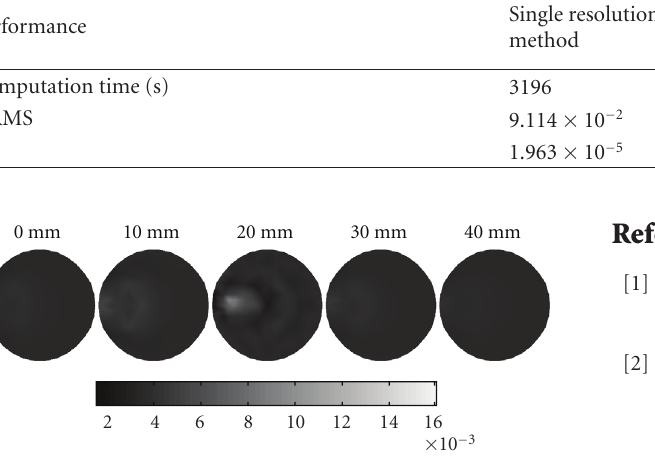
Figure 11: Reconstructed images using the single resolution method, which are 2D cross sections through the reconstructed 3D volume. The right-hand side corresponds to the top of the cylinder ( z = 40mm), whereas the left corresponds to the bottom of the cylinder ( z = 0mm), with each slice representing a 10 mm increment.